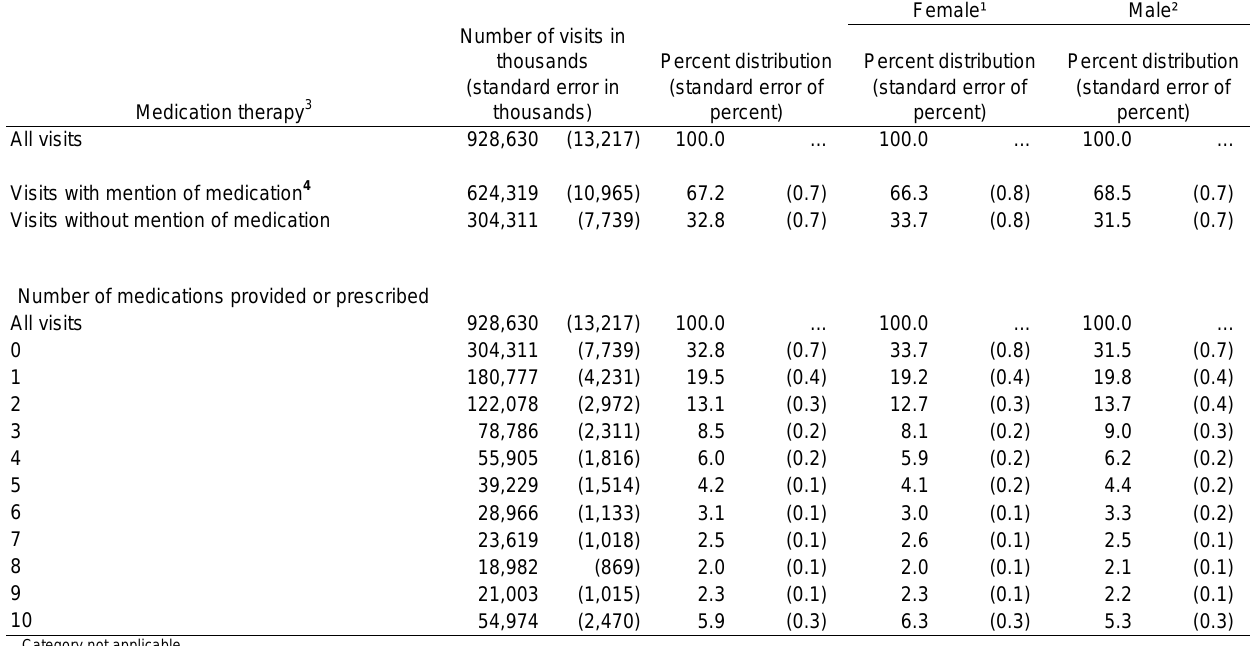
Table 23. Medication therapy and number of medications mentioned at office visits, by patient sex: United States,